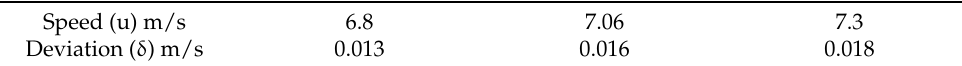
Table 2. Dependence of speeds taking into account the experimental data and the mathematical